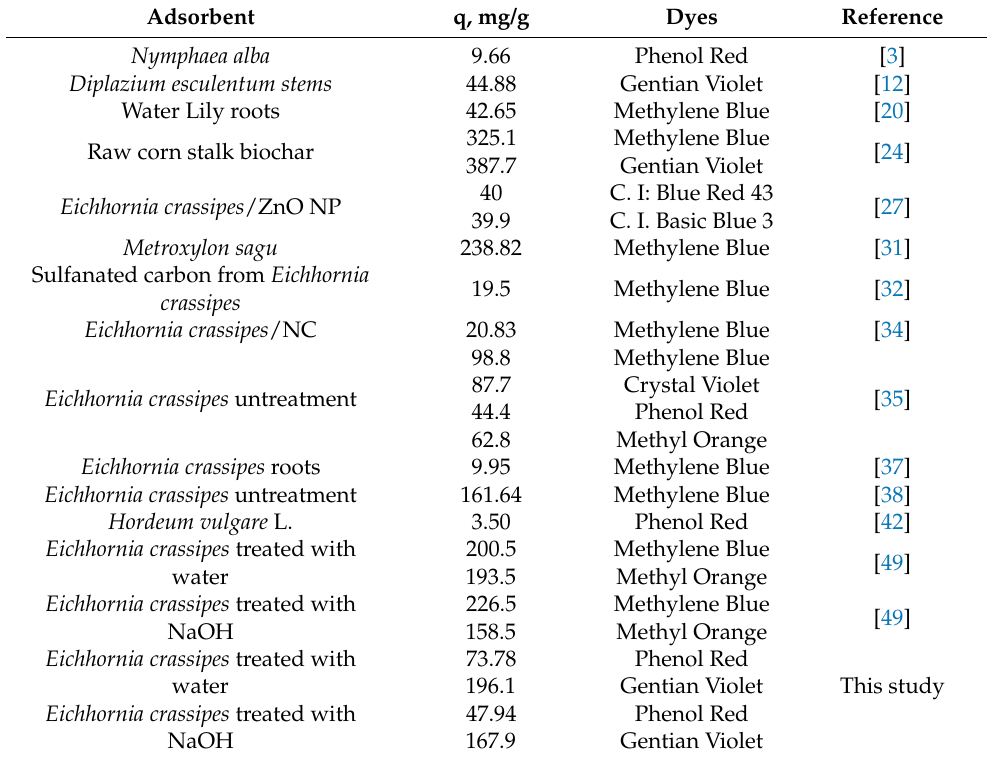
Table 10. Comparison of the adsorption capacity of different bioadsorbents. Adsorbent q, mg/g Dyes Reference Nymphaea